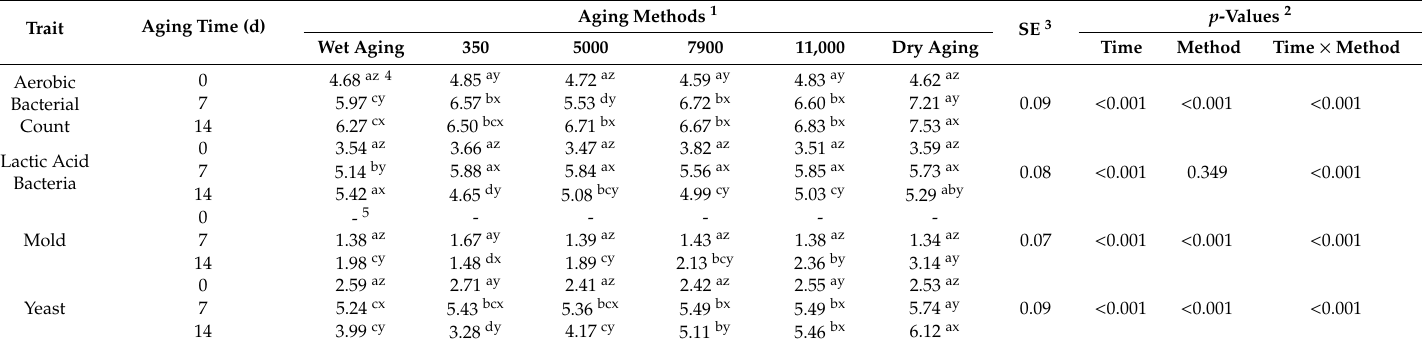
Table 4. E ff ects of di ff erent aging methods and aging time on the microbial population (log colony-forming unit (cfu) / g meat) of beef.